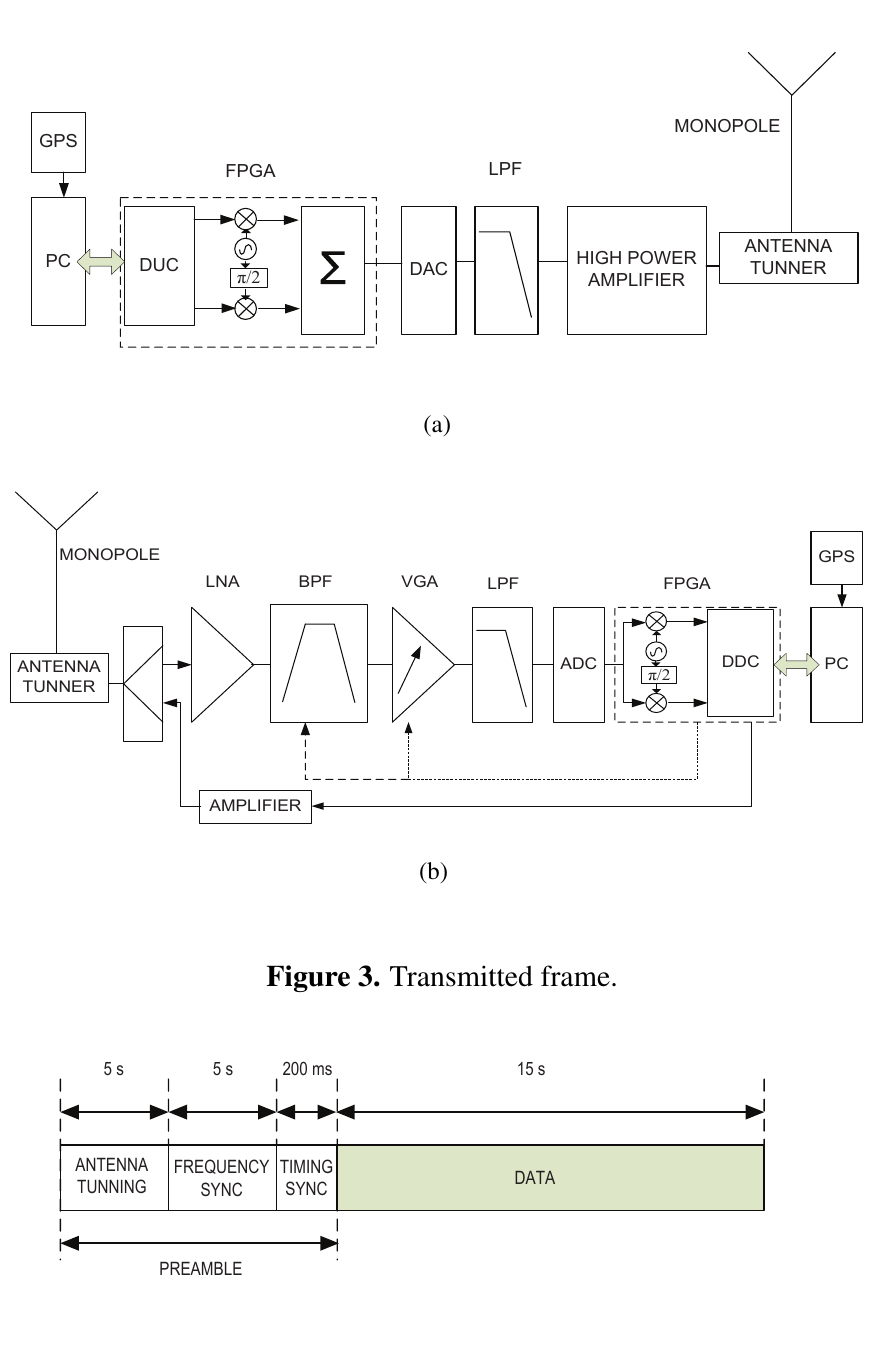
Figure 2. Transmitter (a) and receiver (b) system architecture based on Software Defined Radio Technology.